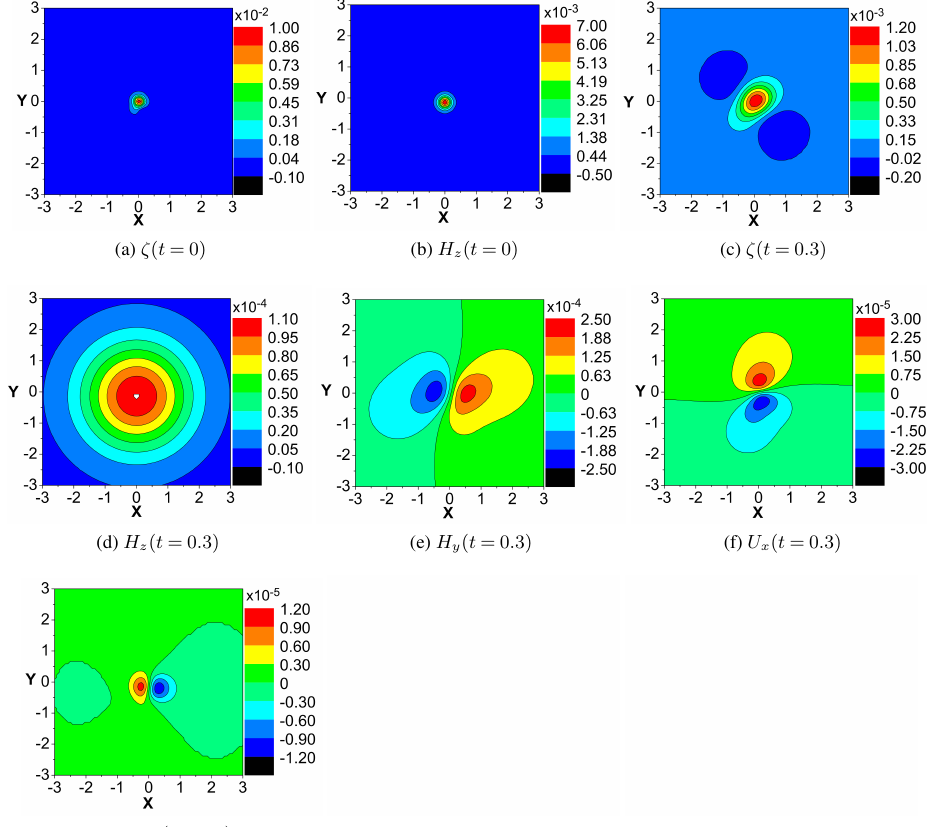
Fig. 5: The spatial distributions of normalised magnetic vortex ζ , components of magnetic field ( H y ,H z ) and velocity ( U x ,U z ) are taken at hight Z = 300 km (night time). PEMW was excited by initial perturbation of H z and ζ ( H z ( t = 0) max = 0 . 05 and ζ ( t = 0) max = 0 . 05 ). For the case (g) H z ( t = 0) max = 0 . 03 and ζ ( t = 0) max = 0 . 03 . For (a-f) ∆ x ζ = ∆ y ζ = 0 . 17 , ∆ x H = ∆ y H = 0 . 17 ; ∆ x 0 H = ∆ y 0 H = 0 and θ = 0 ; for (g) ∆ x ζ = ∆ y ζ = 0 . 35 , ∆ x H = ∆ y H = 0 . 25 ; ∆ x 0 H = ∆ y 0 H = 0 . 2 and θ = 45 ◦ . The scaling of X , Y and normalised values of H are the same as in Figs. 3. The velocity component U z is normalised by V A = 4 . 4 km/s.